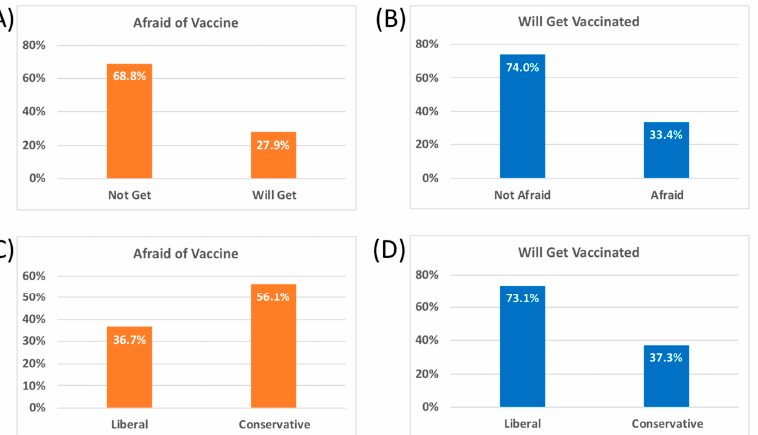
Figure 1. Opinions about the COVID-19 vaccine ( n = 1017). ( A ) Proportion of individuals who report being afraid of the vaccine based on whether they indicate they will or will not get the vaccine. ( B ) Proportion of individuals willing to get vaccinated based on whether they endorsed fear of the vaccine. ( C ) Proportion of individuals reporting fear of the vaccine based on political ideology. ( D ) Proportion of individuals indicating they are willing to get the vaccine based on political ideology.